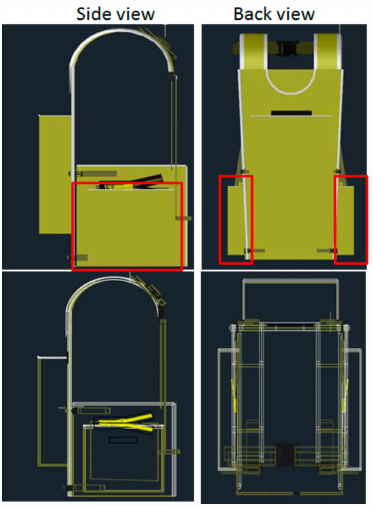
Figure 2. Details of Backpack